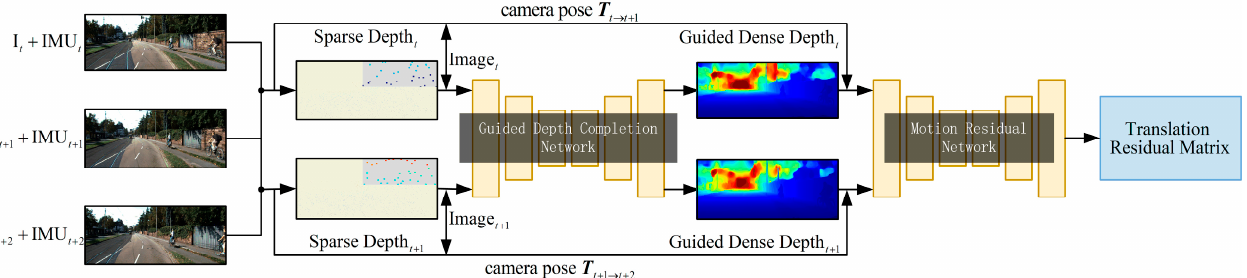
Figure 1. Overall training